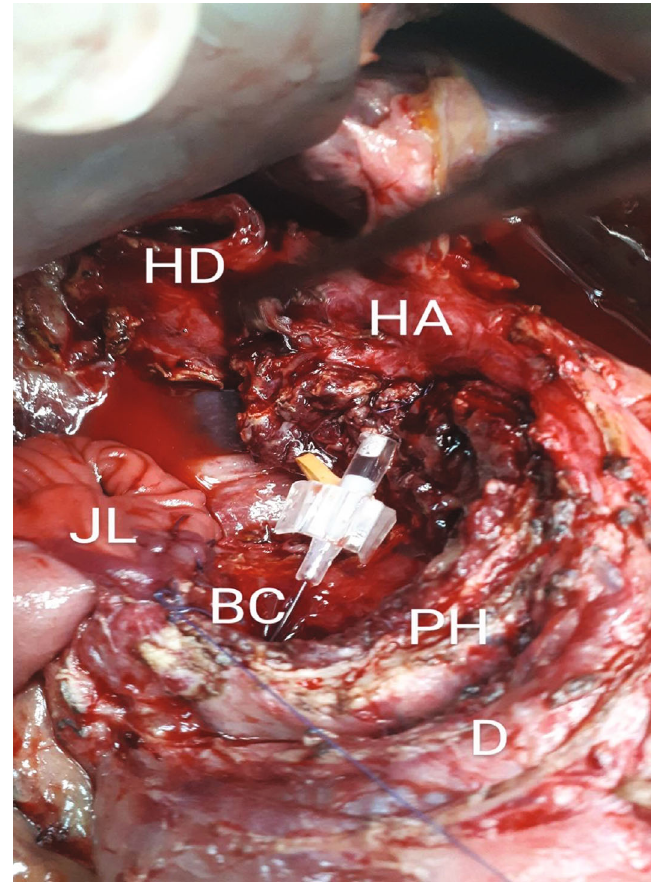
Figure 3: Operating fi eld after cyst resection. Destruction of the posterior side of the pancreatic head with suppressed ventral duodenum. Common bile duct cut immediately below the hepatic ducts con fl uence. Biliary cannula temporarily placed in the ampulla of Vateri for intraoperative orientation (HD: hepatic ducts con fl uence; HA: hepatic artery; JL: jejunal loop; PH: pancreatic head; D: duodenal frame; BC: biliary